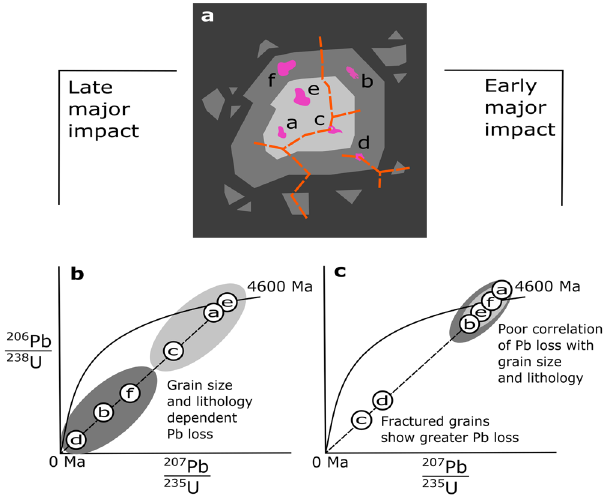
Fig. 3 Scenarios for Pb-loss from Chelyabinsk phosphates during impact. a Schematic view of phosphate grain populations in Chelyabinsk lithologies. Small and large pristine phosphate grains are shown, as well as grains with fracture-damaged domains. b If recent Pb-loss corresponds to a major event of shock metamorphism and post-shock heating, Pb should diffuse more rapidly from smaller grains, and from those grains hosted in the dark lithology (higher peak temperature). c If recent Pb-loss corresponds to a relatively mild heating event that only noticeably affected fractured- damaged grains, Pb-loss will have been stochastic, possibly independent of grain size, occurred throughout both lithologies equally, and will be more developed in fracture-damaged rather than pristine grain populations. Colour-scheme interpretation is the same as in Fig.